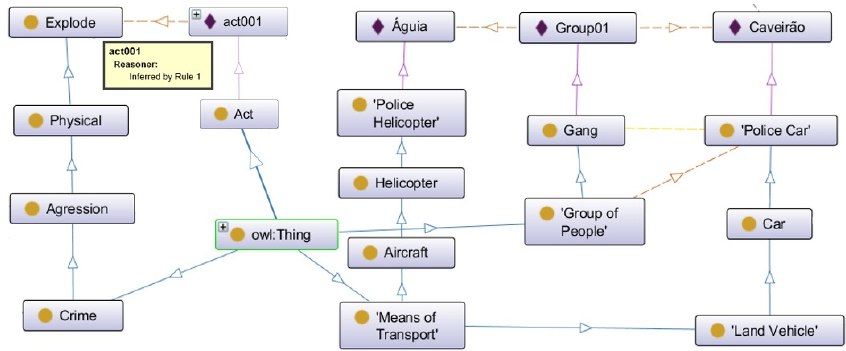
Figure 6. Partial representation of the Tweet (example) instantiated in the OntoCexp. Listing 1. Examples of inference rules related to criminal acts specified in the